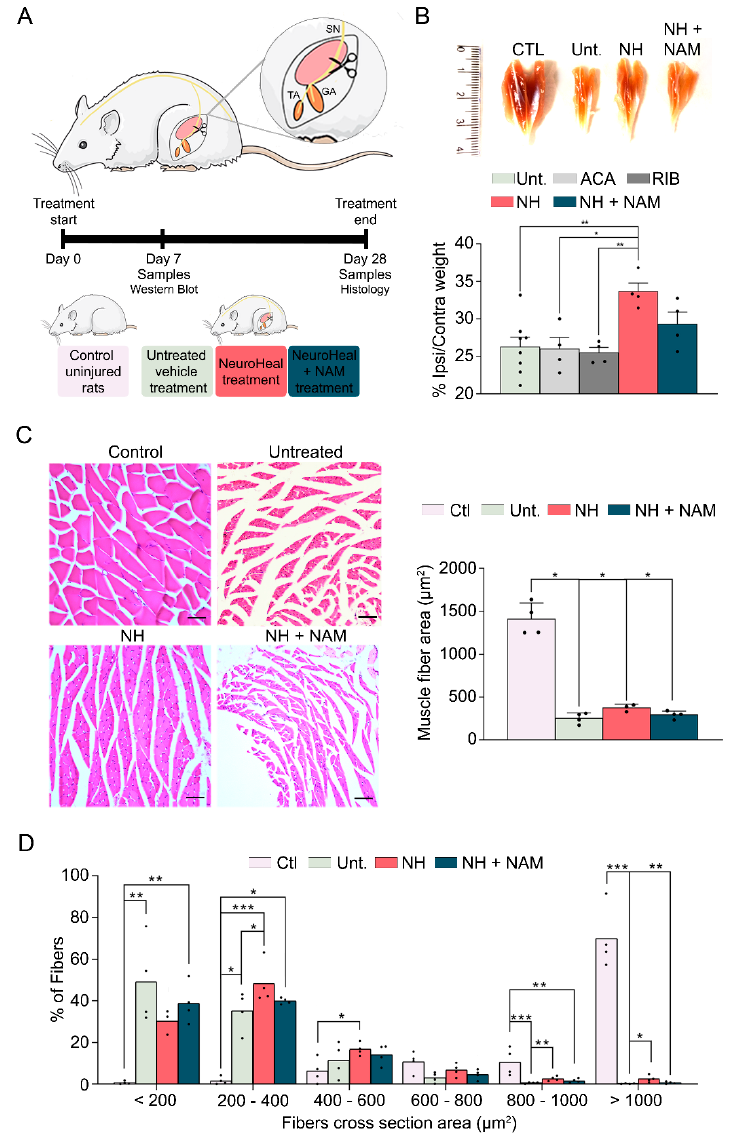
Figure 1. NeuroHeal treatment reduces muscle atrophy by denervation. ( A ) Schematic workflow and experimental groups and ( B ) representative photographs of the gastrocnemius (GA) muscles removed from different experimental groups: control (CTL), injured untreated (Unt.), injured treated with NeuroHeal (NH), and injured treated with NH plus nicotinamide (NAM). Bar graph of the relative average weight of the ipsilateral muscle with respect to the contralateral one from different groups including those animals treated with acamprosate (ACA) or ribavirin (RIB) alone at 28 days post-injury (dpi) ( n = 4; one-way ANOVA, * p < 0.05) is shown. ( C ) Left, representative microphotographs of cross GA muscle sections with Hematoxylin and Eosin (H&E) staining at 28 dpi (scale bar = 100 µ m) and, right, representation of cross-sectional area ( µ m 2 ) mean of all fibers in the GA muscle ( n = 4; one-way ANOVA * p < 0.0001). ( D ) Histogram of the cross-sectional area ( µ m 2 ) distribution of fibers in the GA muscle of di ff erent groups ( n = 4; Kruskal–Wallis, Benjamin, Krieger, and Yekutieti post hoc * p <